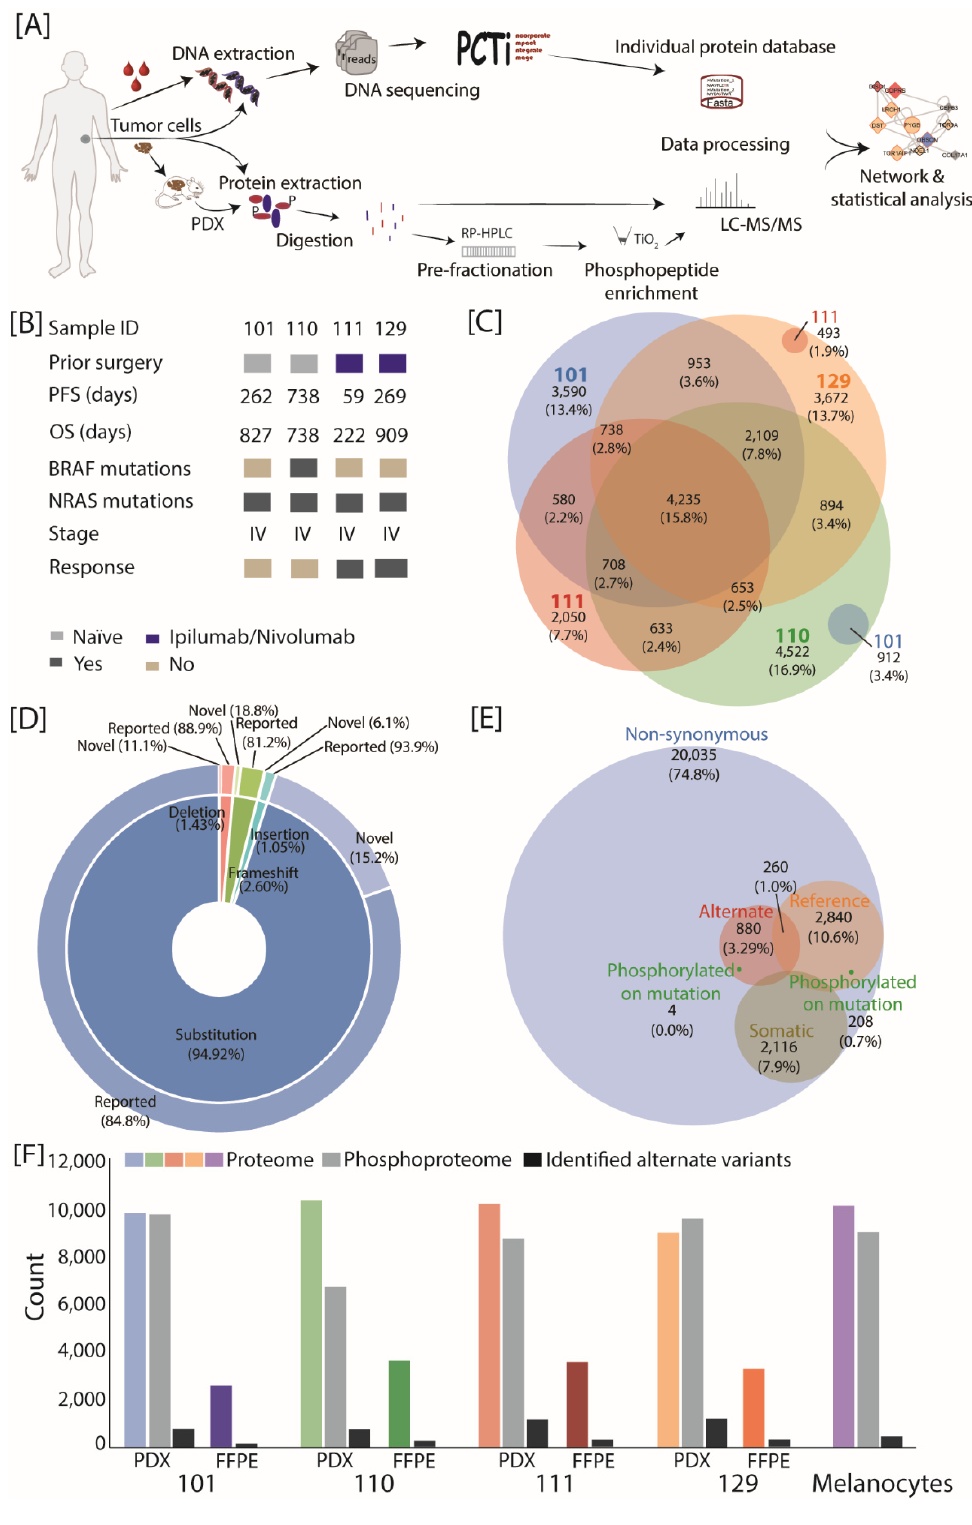
Figure 1. The mutational landscape of melanoma patients in response to immunotherapy. ( A ) Schematic overview of the proteogenomic workflow. Whole blood and tumor tissue of four patients were used in this study. Metastatic tumor tissue was injected into an immune-deficient mouse to generate patient-derived xenografts (PDX). For whole exome sequencing, DNA was extracted from whole blood and metastatic tissue and sequenced on an Illumina sequencing instrument. Indi- vidualized protein databases and impact files were generated with an in-house bioinformatic pipeline. For the proteomic workflow, FFPE specimens from the same tissue as well as patient-derived xenografts tissue were used. Cells were lysed and proteins were digested using trypsin. The resulting peptide mixture from the PDX material was fractionated using an off-line RP HPLC operated at a high pH. Fractions were pooled and measured directly or applied to